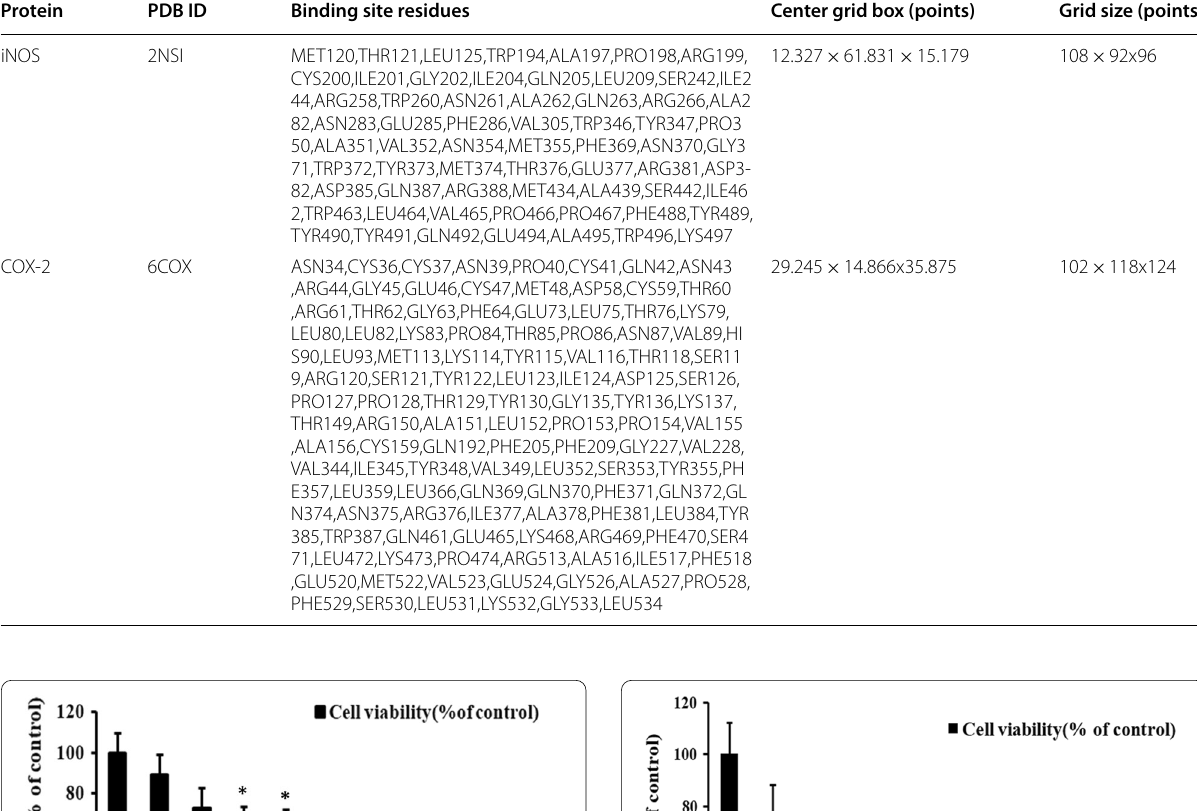
Table 3 Grid box parameters for docking and binding site residues Protein PDB ID Binding site residues Center grid box (points)